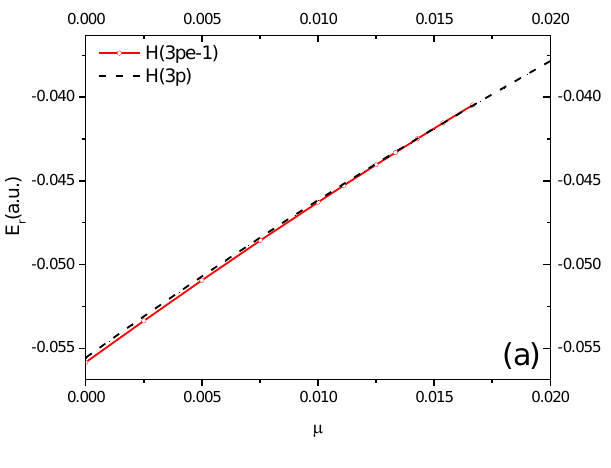
Figure 6. Cont. Figure 6. Cont.